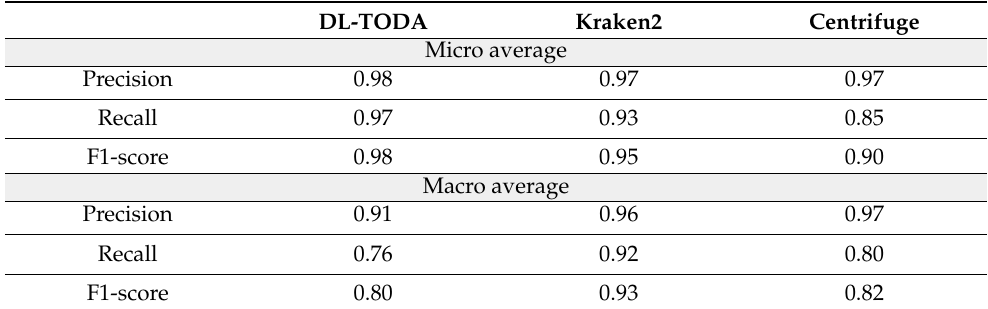
Figure 6. Accuracy across taxa at different taxonomic ranks obtained by running DL-TODA, Cen- trifuge and Kraken2 on ten subsets of the testing set. The error bar is plotted at the top of each bar. Results for DL-TODA are reported in the presence of a decision threshold of 0.8. Table 3. Micro average and macro average of precision, recall and F1-score obtained for the 639 species in the testing set for DL-TODA, Kraken2 and Centrifuge. The DL-TODA metrics were calculated with testing reads classified with a probability score higher than